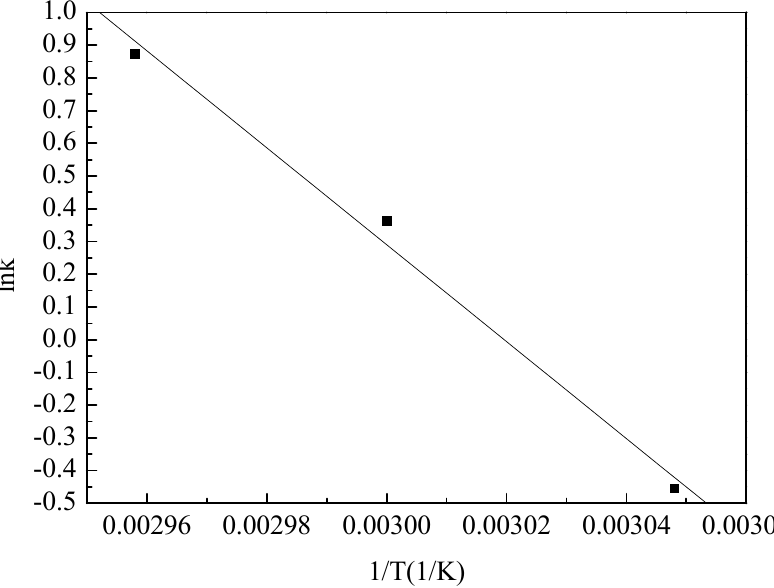
Figure 7. First order reaction rate constant in an Arrhenius plot of waste cooking oil in methanol